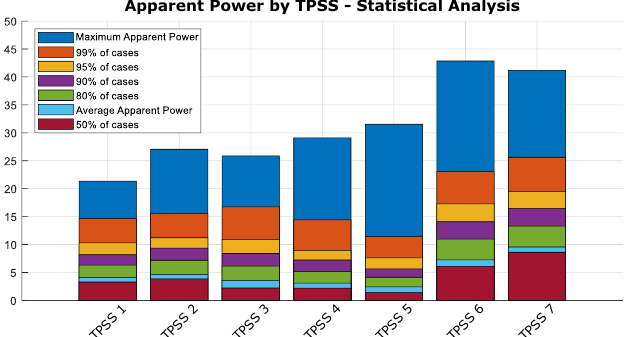
Figure 5. The range of apparent power in percentages per number of